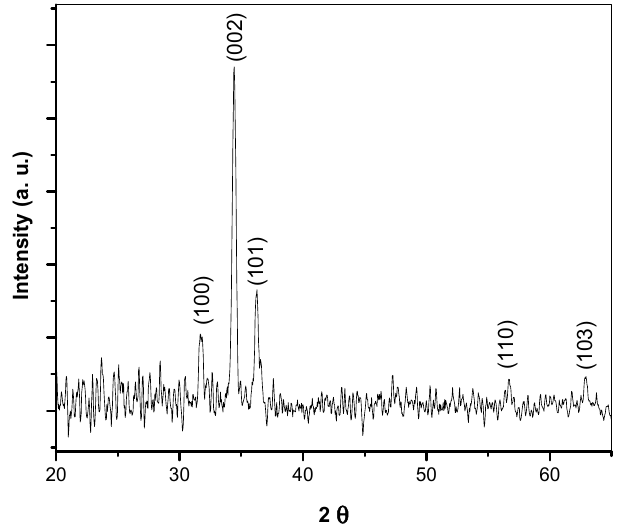
Figure 1. XRD pattern of annealed ZnO film.